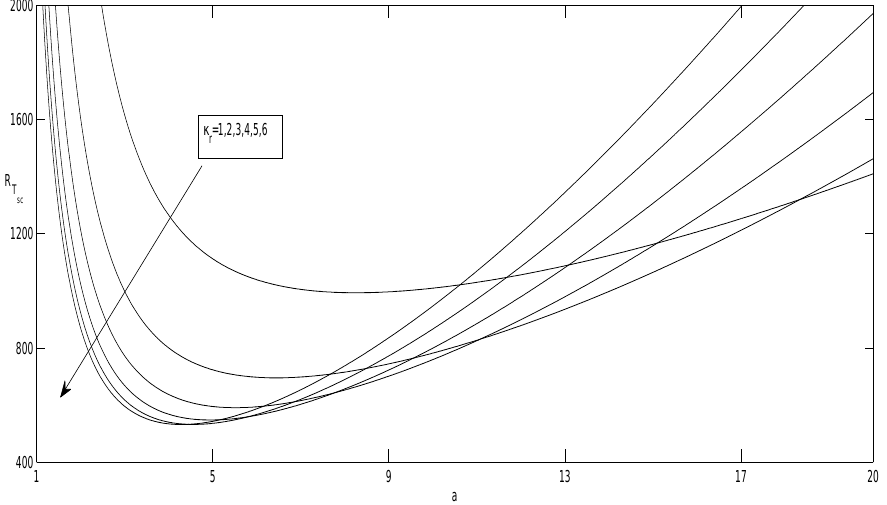
Figure 8. Neutral curves for the different values of κ r , and for the fixed values of γ = 0.5, η = 0.2, Ta = 50 and R C = 100 for the oscillatory